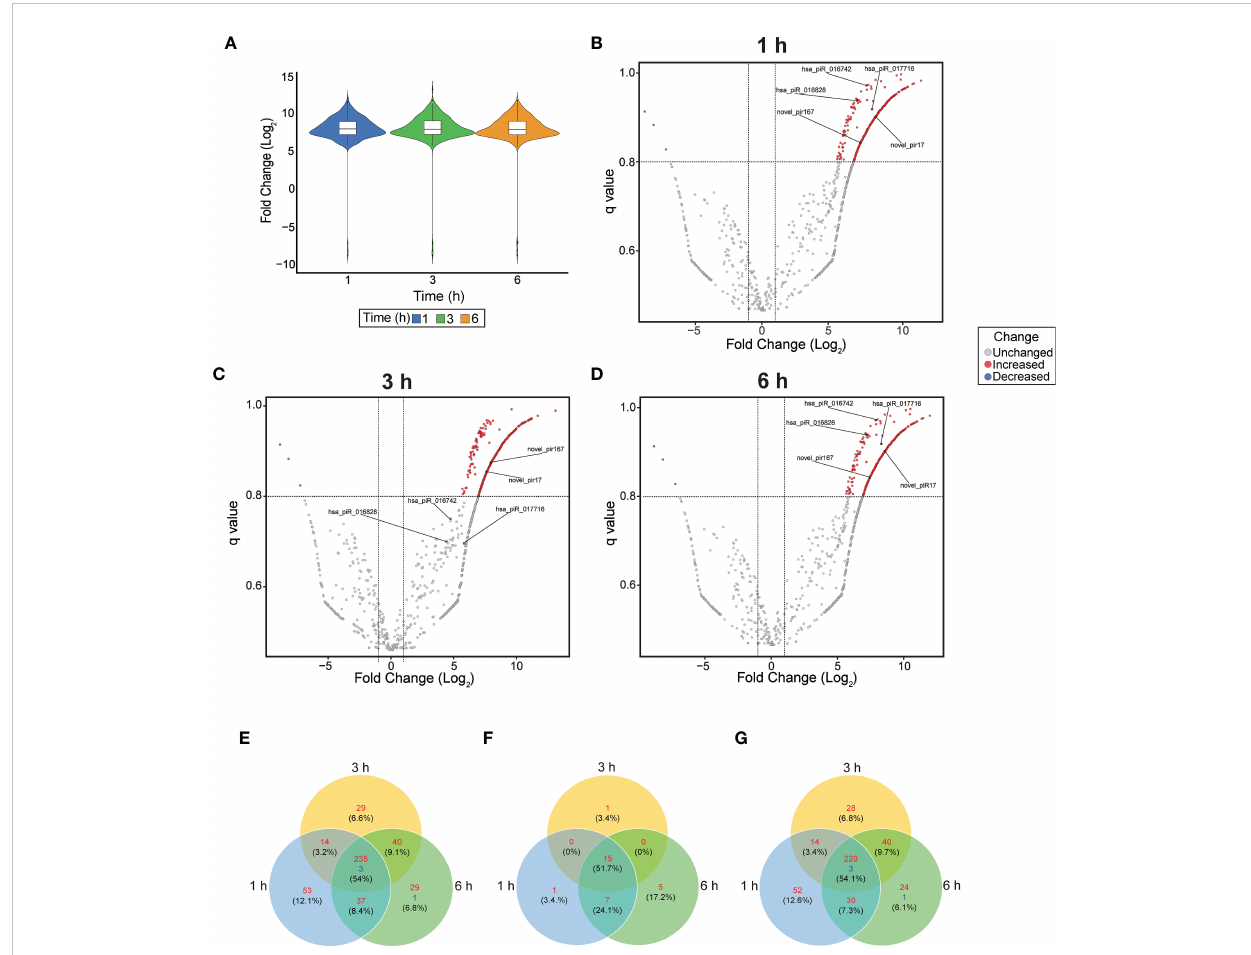
FIGURE 2 Dysregulation of piRNA expression in during early T. cruzi infection of PHCF. (A) Violin Plot of differentially expressed piRNA at each time point. The boxplot indicates the median, quartiles, and extremes of piRNA fold change. The width of the colored areas represents the proportion of piRNAs exhibiting a given level of expression. Volcano plots of piRNA expression at 1 (B) , 3 (C) , and 6 (D) hours post- T. cruzi challenge. The x-axis indicates the log 2 Fold change relative to the 0-hour control. The y-axis shows the q value. Upregulated and downregulated piRNAs are shown in red and blue, respectively. The criteria for statistically signi fi cant differential expression was log 2 Fold change >1, q >.8, and are indicated by the x-intercept and y-intercepts. The 5 selected piRNAs evaluated in our study are labeled in each plot. (E) Venn diagram of all upregulated (red) and downregulated (blue) piRNAs at various time points after T. cruzi challenge with FDR < 0.05. (F) Venn diagram of known piRNAs and (G) putative piRNAs dysregulated over the course of infection. These piRNAs previously not published have been deposited into NCBI SRA